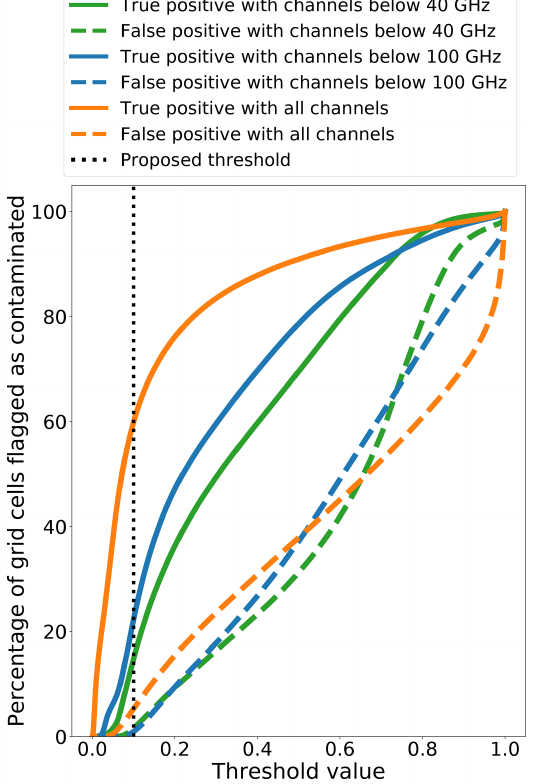
Figure 5. Evolution of the percentage of MW observations cor- rectly classified as cloud contaminated (true positive, solid lines), and clear-sky grid cells incorrectly classified as being contaminated (false positive, dashed line), as a function of the NN output thresh- old for the three MW frequency ranges. Note that, for this data set, half the observations are cloudy according to